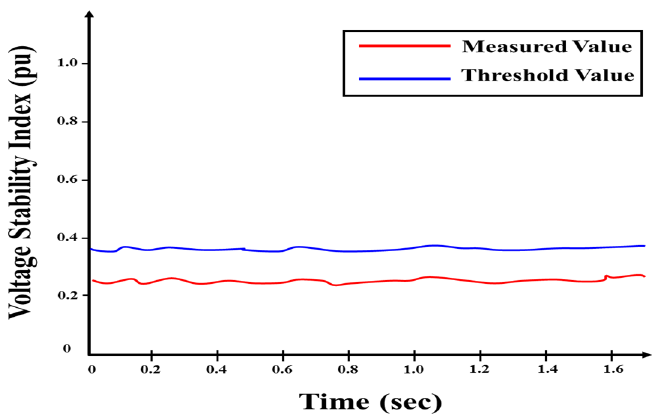
Figure 19. Observation for the measured data and threshold value with severe contingency.